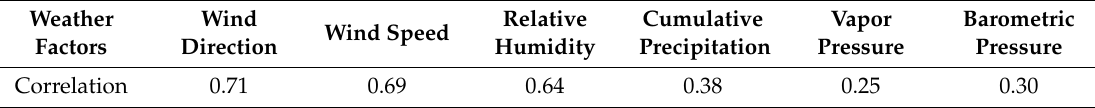
Table 1. Comparison of correlation coe ffi cients between temperature and other weather